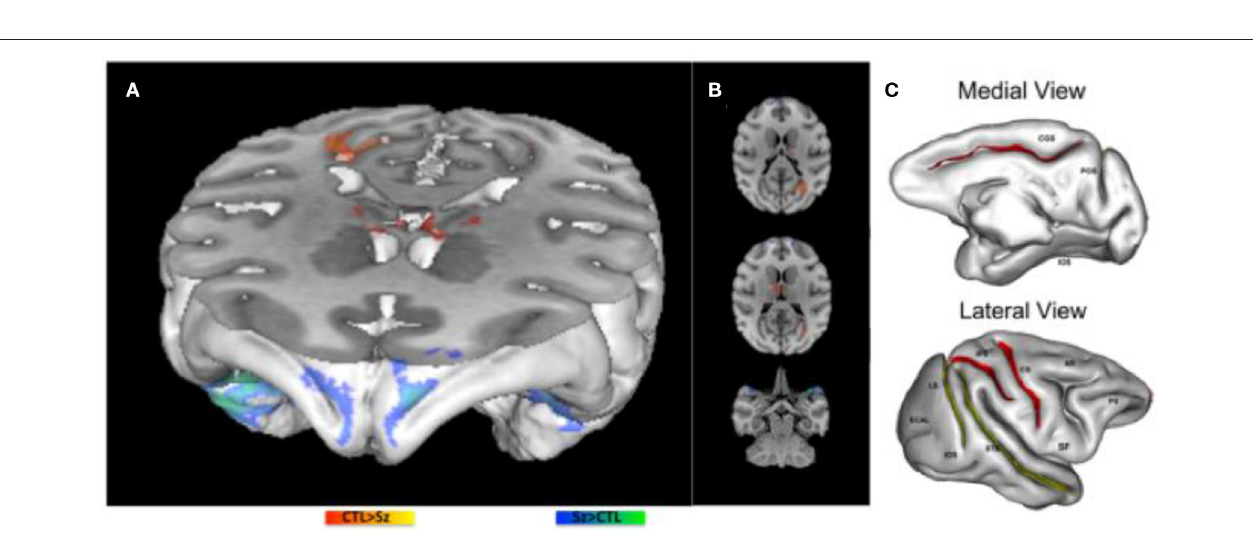
FIGURE 1 | Craniofacial trauma and colpocephaly. (A) Demonstrates periorbital scarring due to repeated craniofacial trauma due to seizures. (B) Shows normal ventricular configuration (upper series) and enlarged occipital horns (lower series). Adapted from Comparative Medicine , references (33, 34), respectively.